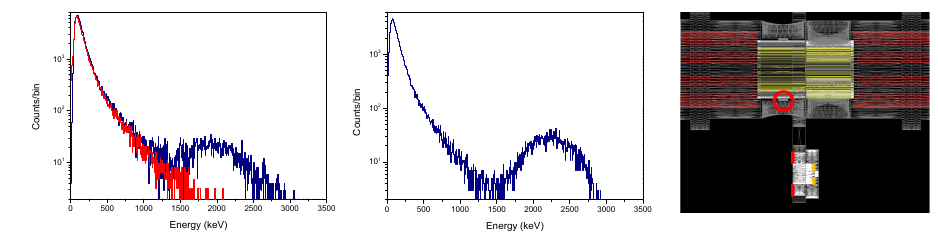
Figure 2. Left panel: the blue histogram is the experimental energy spectrum for one run where the 6 He was implanted on the collimator. The red histogram is the deposited energy spectrum obtained with simulation, normalized to the experimental data. Center panel: the deposited energy spectrum obtained with a simulation where the source of electrons is placed on the outer surface of the collimator. Right panel: the two detectors with the collimator built in GEANT4. The orange and red lines represent respectively the position of the source of events on the inner and outer surface of the collimator. The red circle shows the position of the hole through which the electrons of the decay on the collimator were able to access the YAP scintillator.